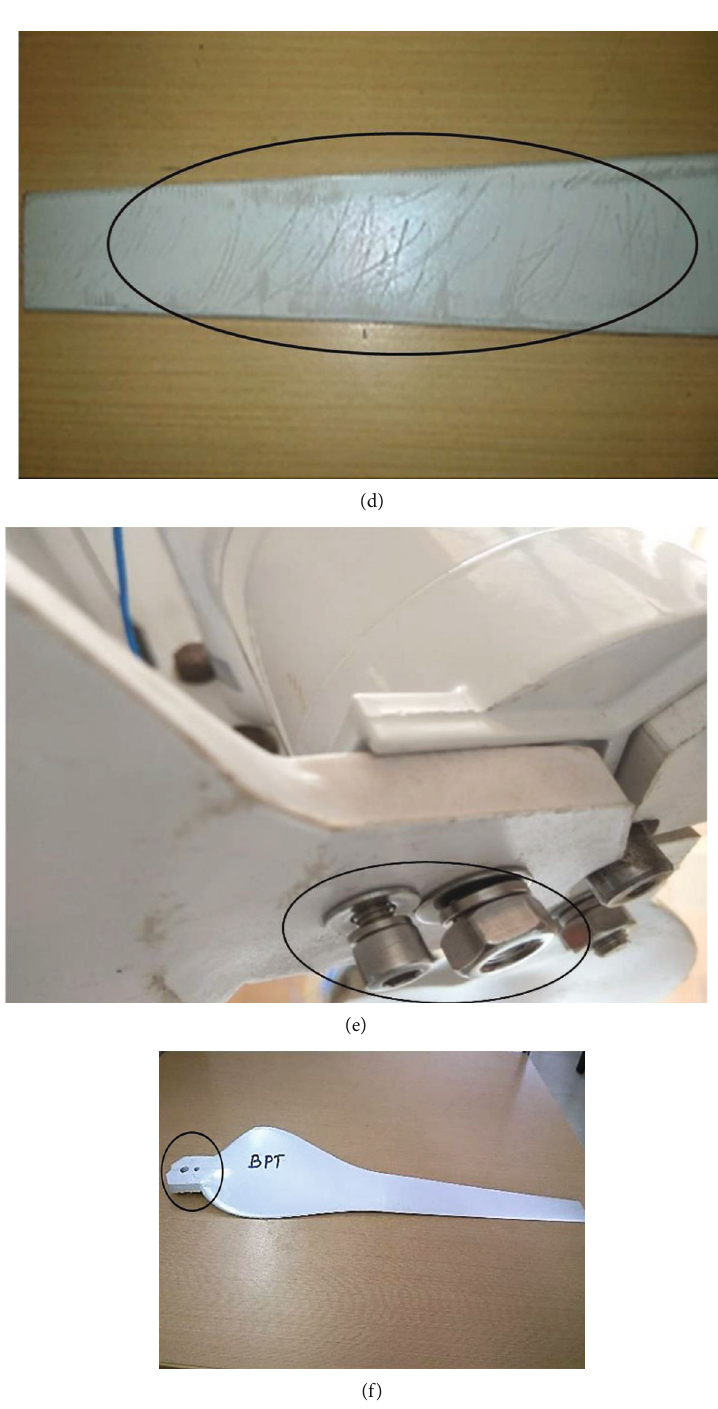
Figure 3: (a) Good blade. (b) Bend fault. (c) Crack fault. (d) Erosion fault. (e) Hub-blade loose fault. (f) Pitch